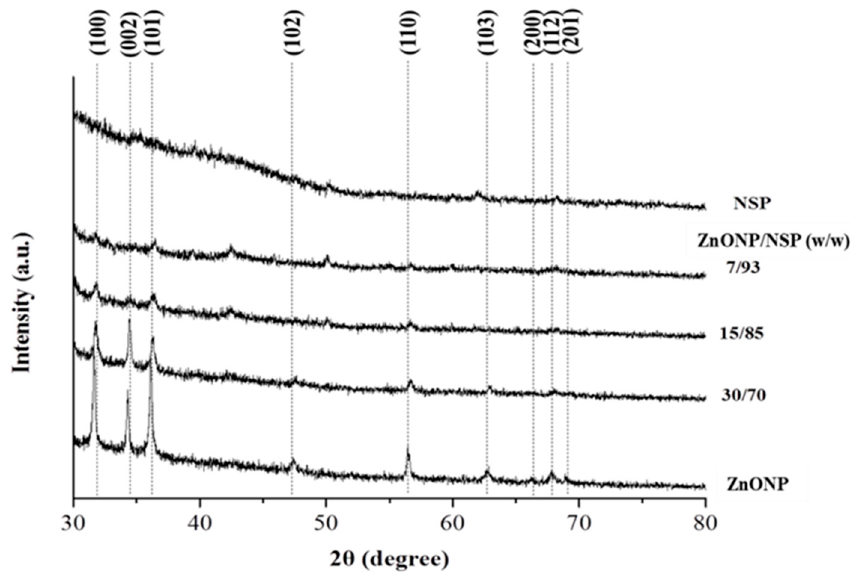
Figure 2. X-ray diffraction patterns of NSP, ZnONP/NSP ( w / w = 7/93, 15/85, and 30/70) and Figure 2. X-ray di ff raction pa tt erns of NSP, ZnONP/NSP ( w / w = 7/93, 15/85, and 30/70) and pristine Figure 2. X-ray di ff raction pa tt erns of NSP, ZnONP/NSP ( w / w = 7/93, 15/85, and 30/70) and pristine Figure 2. X-ray di ff raction pa tt erns of NSP, ZnONP/NSP ( w / w = 7/93, 15/85, and 30/70) and pristine pristine ZnONP without NSP. ZnONP without NSP. ZnONP without NSP. ZnONP without NSP.